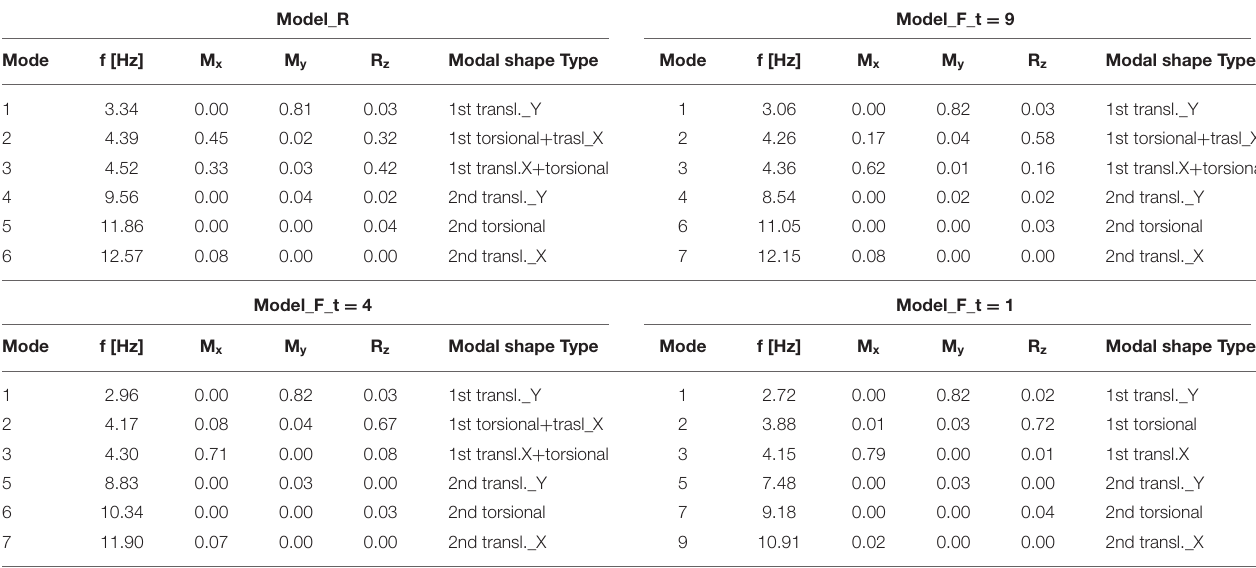
TABLE 4 | Modal properties of the infilled models with different in-plane stiffness of the diaphragm.